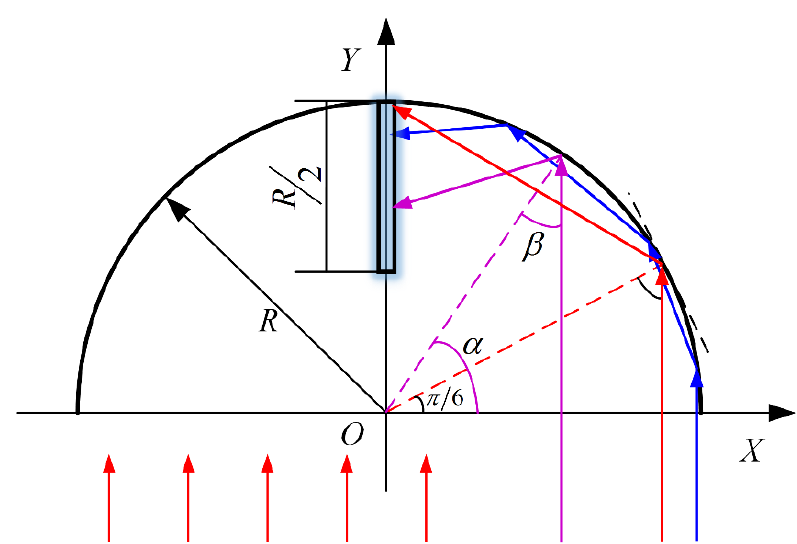
Figure 2. Light propagation process under spherical reflection.